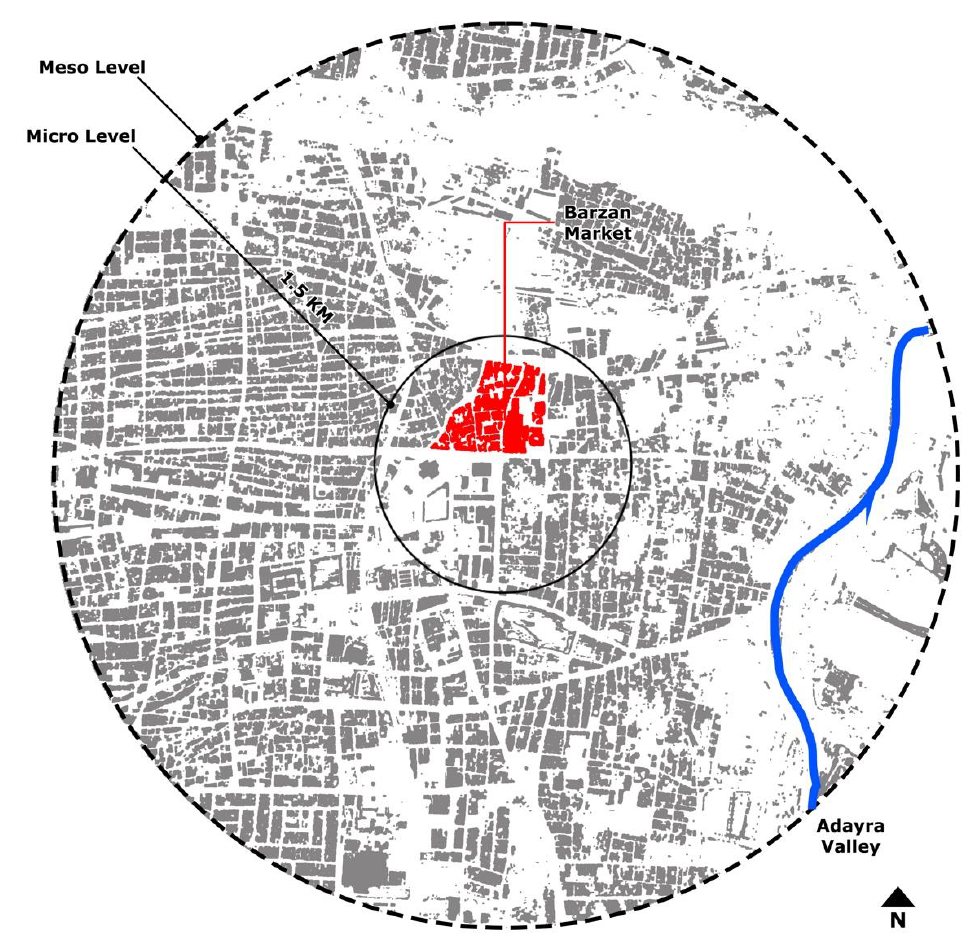
Figure 8. Barzan Market location within Hail City. Source: Authors.